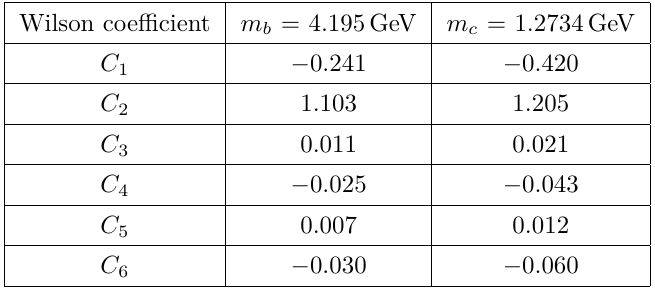
Table 1 . Wilson coefficients at the b - and c -scale, taking tree-level matching and one-loop RG running effects into